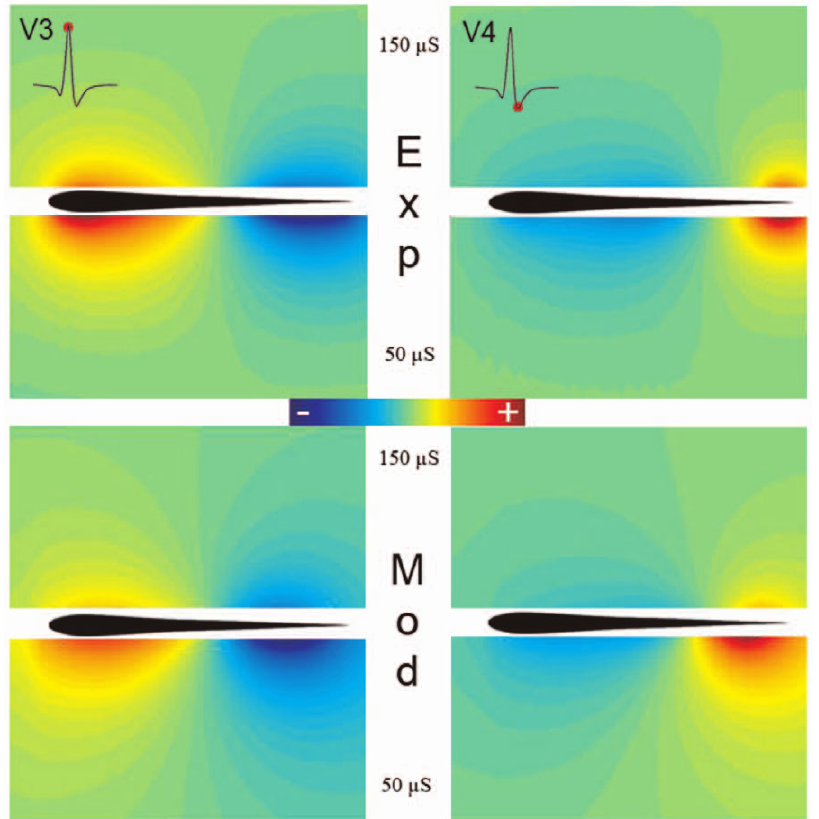
Figure 2. Comparison between the fields of the electric potential generated by G. omarorum and MoGO at two different conductances of 150 and 50 m S/cm. The upper pictures show the experimental results for V3 (left) and V4 (right) using two medium conductances, 150 m /cm (upper halves) and 50 m S/cm (lower halves). The two lower pictures were the same results determined by the MoGO.